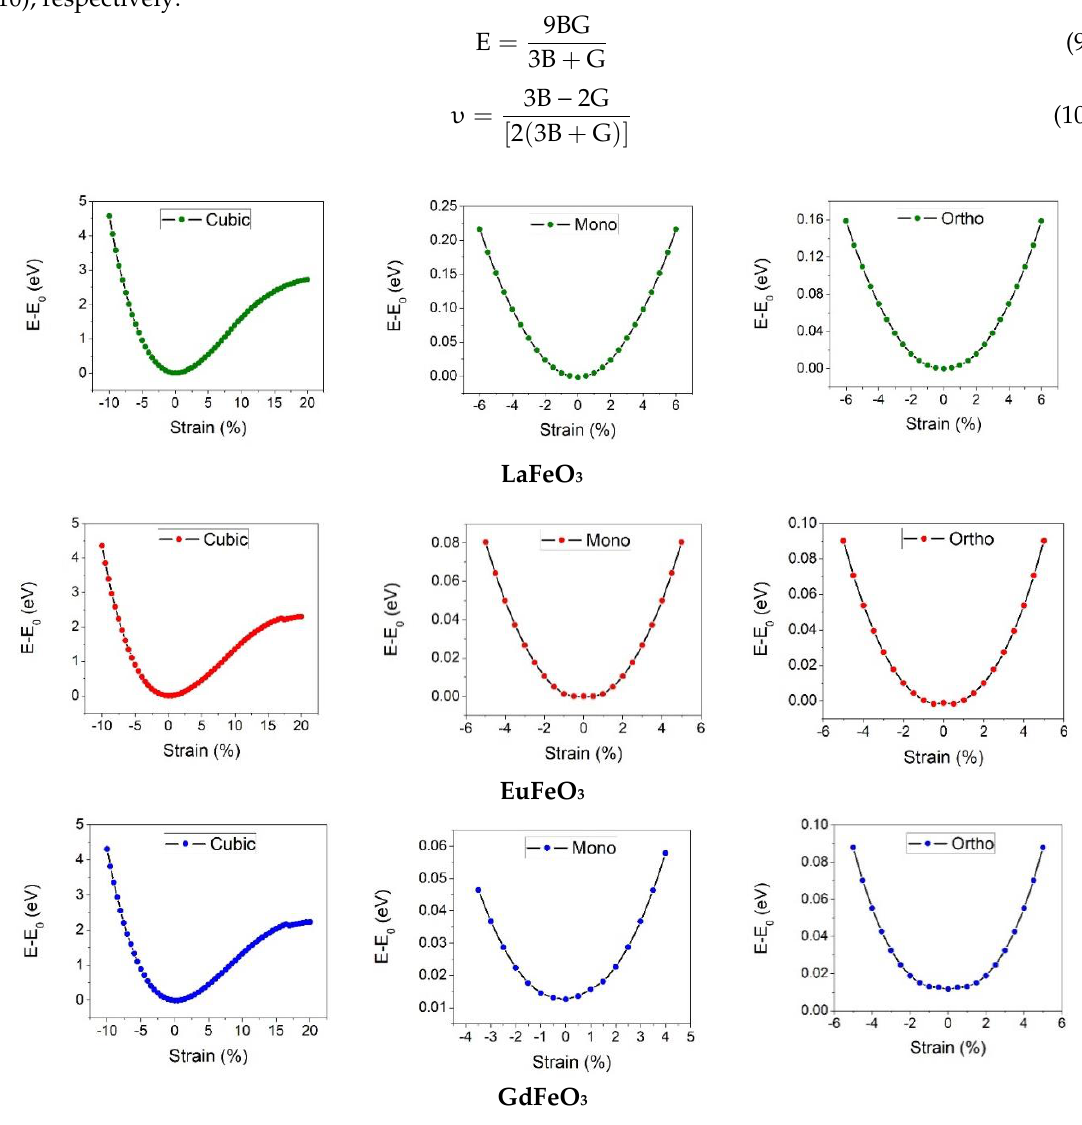
Figure 2. Total energy of LaFeO 3 , EuFeO 3 , and GdFeO 3 structures as a function of strain under the influence of three types of deformation tensor (E 0 is total energy of equilibrium structure).